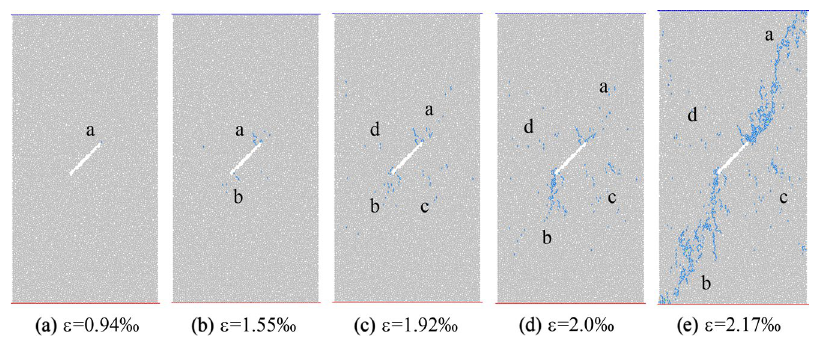
Figure 14. Failure process of specimen under uniaxial compression under uniform